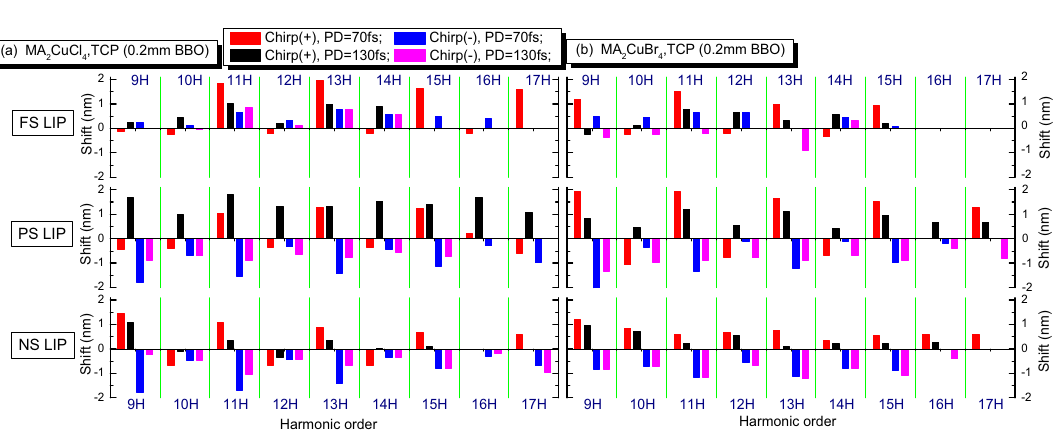
Figure 6. Spectral shifts (in nm) for the harmonics varying from 9 to 17H orders in the case of FS- to NS-induced LIPs for MA 2 CuCl 4 ( a ) and MA 2 CuBr 4 ( b ) perovskites in the case of TCP scheme. PD: pulse duration, Chirp( +): positively chirped pulses, Chirp(-): negatively chirped the harmonics from the red and blue spectral components of the driving pulses, respectively, which led to the red and blue shifts of harmonics. These modifications of harmonic spectra can be used for application in the nonlinear spectroscopy of materials using tunable coherent XUV pulses. The summarized spectral shifts of harmonics are presented in Fig. 6. We note that, in the case of two-com- ponent harmonics showing their splitting, the largest shift of the wavelengths of blue and red components was obtained. We observe a clear dependence of this process on the type of HP. In the case of the FS LIP, the blue shift was suppressed, while in the case of NS LIP we obtained the smallest red shift. For low orders of harmonics, the red/blue shifts are bigger than for higher orders, which could not be explained by a simple model, where only spectral components of leading part of the pump pulse play a decisive role in HHG. In addition to the findings reported in 46 , we showed the spectral broadening and the appearance of two, redder and bluer, spectral components at two pulse durations of the chirped pulses. Also, in the case of the low fluence FS HP we found the absence of the blue-shifted harmonics generation, which contradicts previous